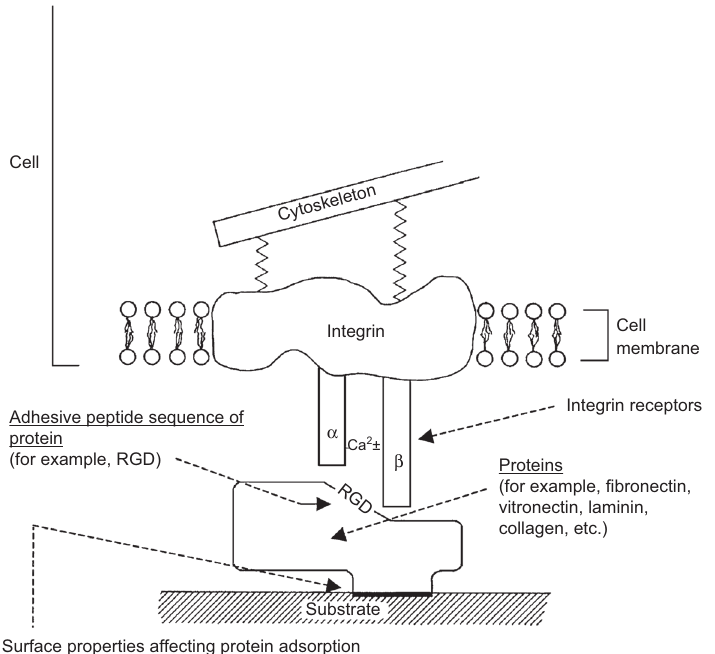
Figure 1 Initial protein interactions leading to cell recognition of implants